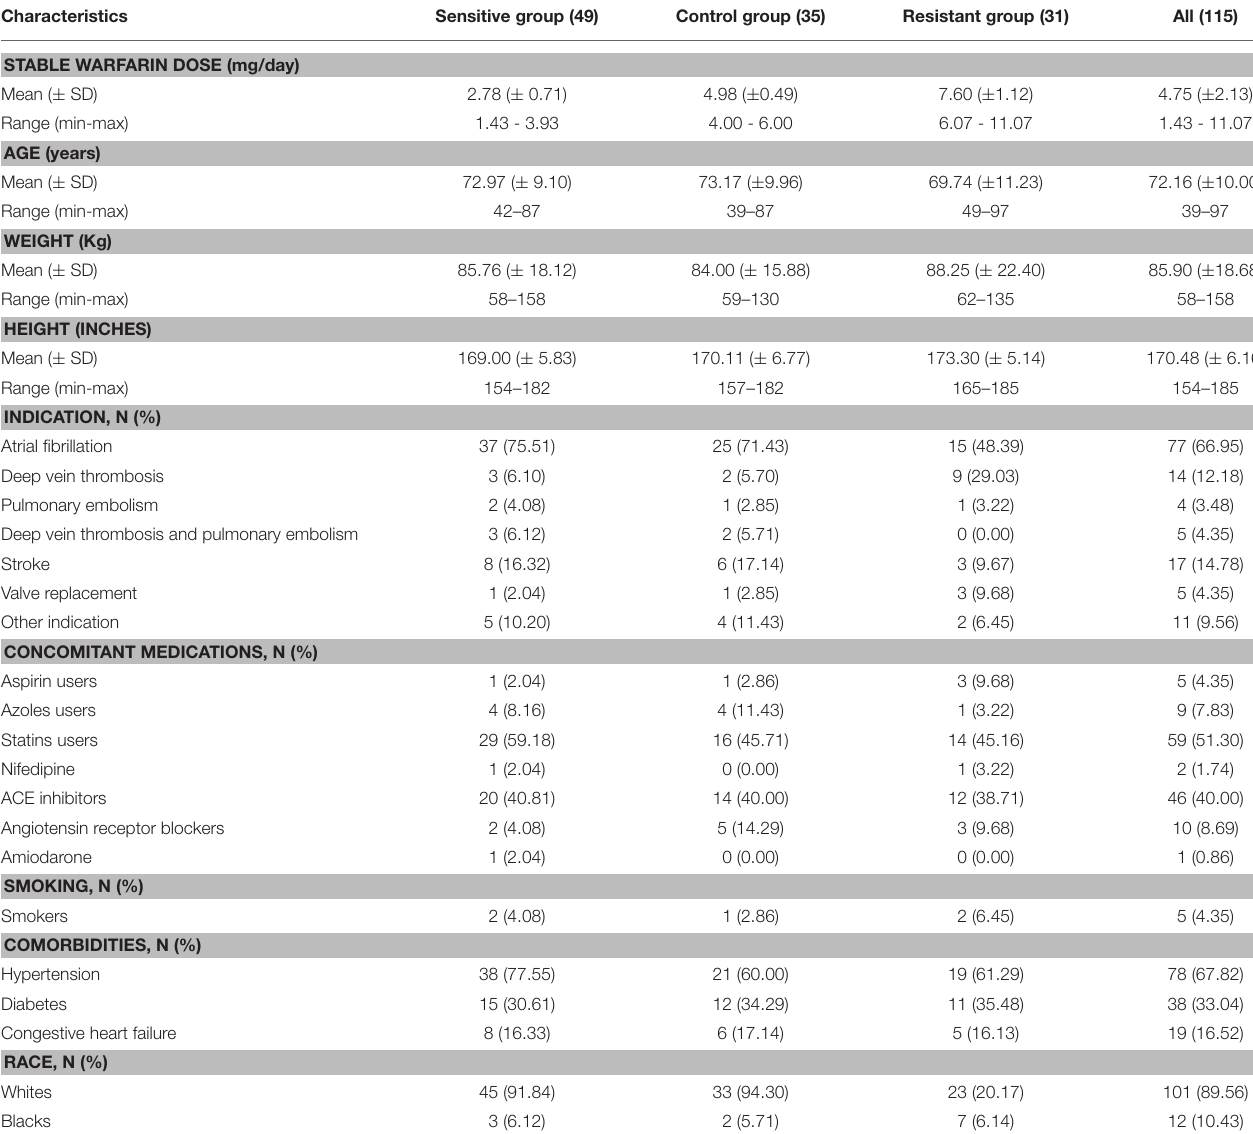
TABLE 1 | Clinical and demographic characteristics of participants.